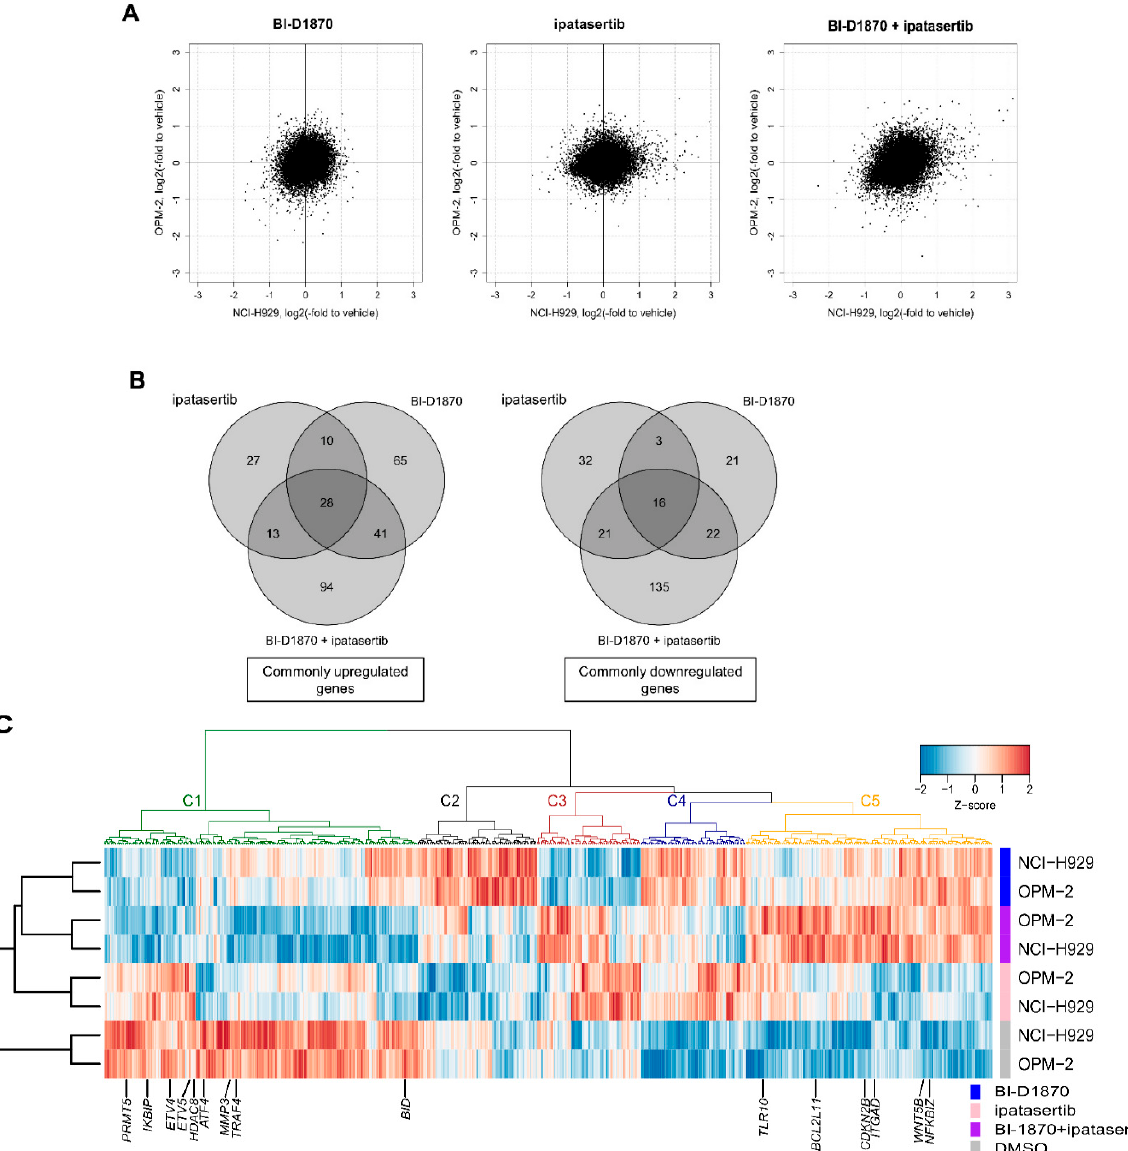
Figure 4. Gene expression change induced by BI-D1870, ipatasertib, or their combination in HMCLs: ( A ) Expression changes in all investigated genes relative to vehicle cells in NCI-H929 ( X -axis) and OPM-2 cells ( Y -axis). ( B ) Venn diagrams for numbers of commonly significantly upregulated (left) and downregulated (right) genes in NCI-H929 and OPM-2 cells. ( C ) Clustering of significantly modulated genes after treatment in NCI-H929 and OPM-2 cells. Table 1. List of significantly modulated genes by the treatment with the combination of BI-D1870 and ipatasertib. Gene lists of the clusters C1 and C5 in Figure 4C.